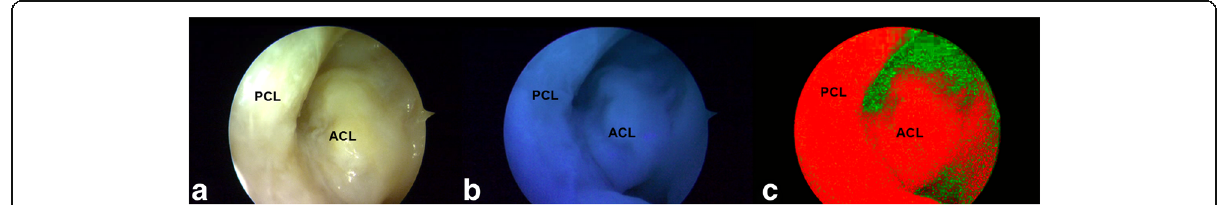
Fig. 6 Arthroscopic view of a cadaveric human femoral insertion site. Consecutively shown in white light mode ( a ), fluorescence mode ( b ), and spectral unmixed mode ( c